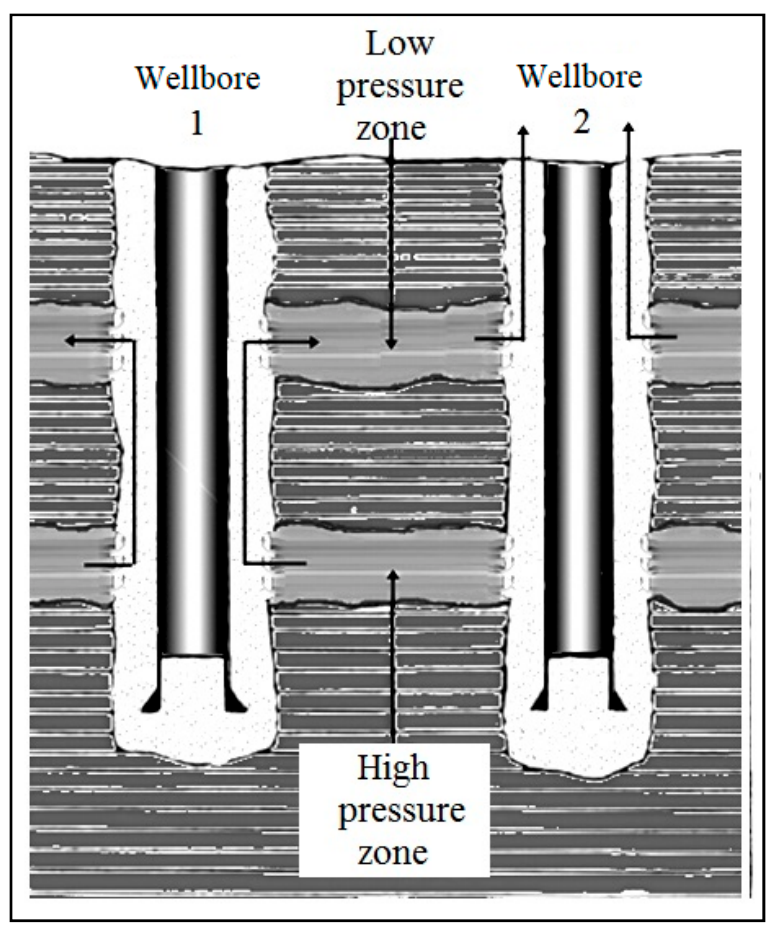
Figure 1. Example of gas migration and exhalation.